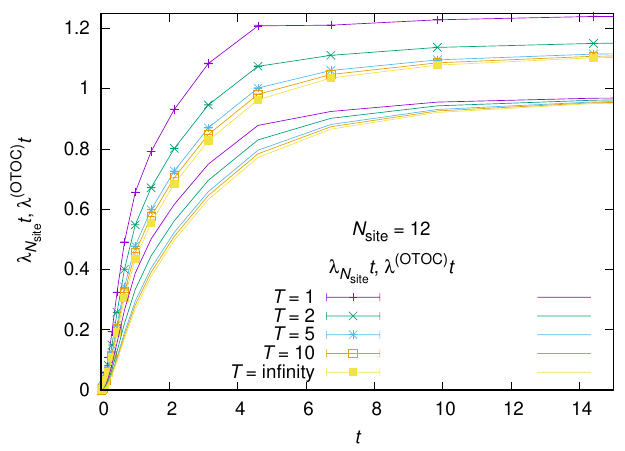
Figure 12 . (cid:21) N t (with data points and error bars) and (cid:21) (OTOC) t (with the same color as (cid:21) N site but data points omitted) plotted against time t for the XXZ model with N site = 12, W = 0 : 5 and various temperatures T . 215 samples have been used for each data point.